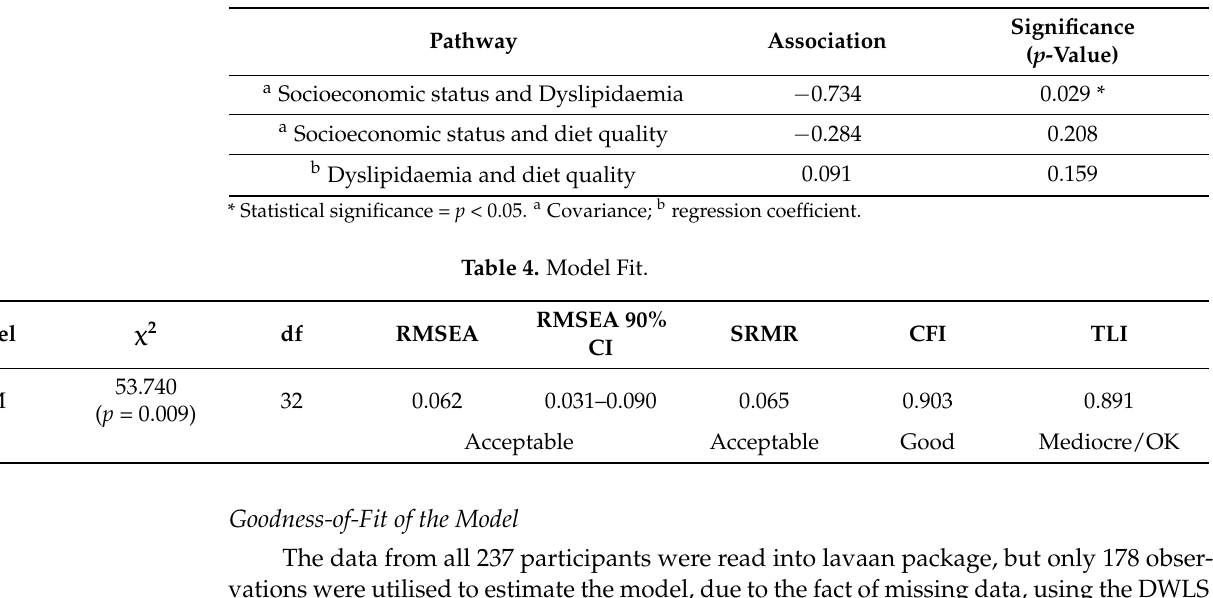
Table 3. Structural equation model of the relationships between socioeconomic status, diet quality and dyslipidaemia.